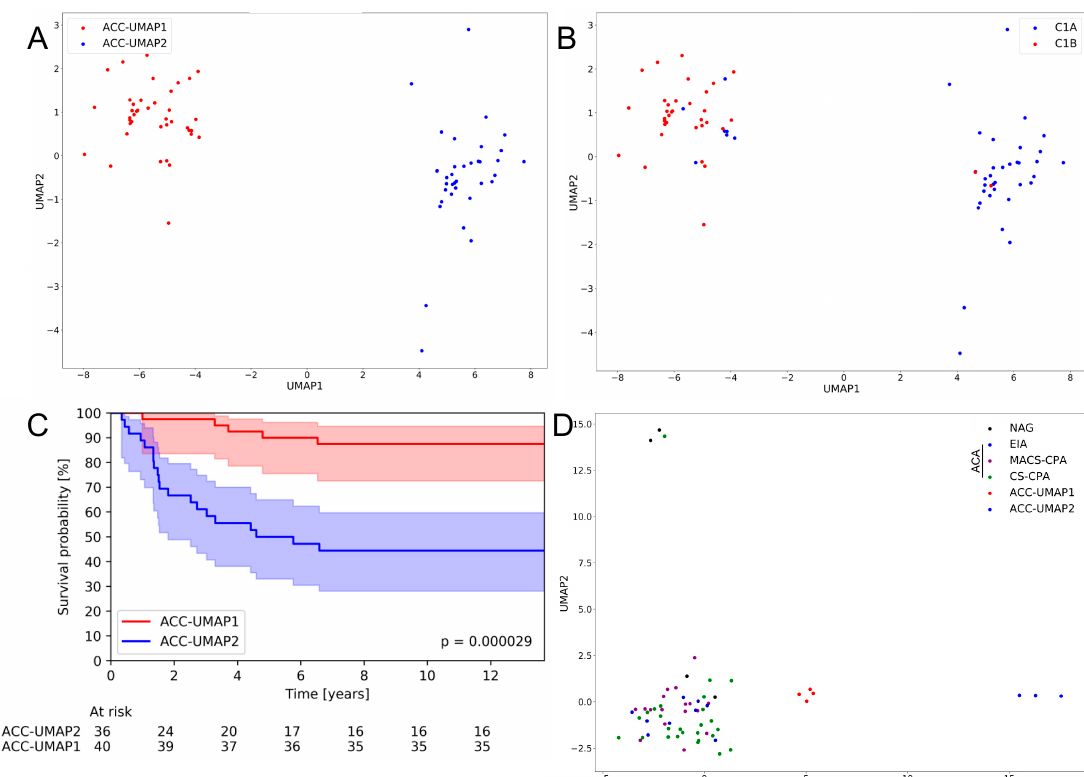
Figure 1. UMAP cluster representation of different mRNA expression patterns. Representation of the UMAP (uniform manifold approximation and projection) clustering of the ACC-TCGA dataset without outliers ( A ) and the overlap with C1A/C1B clustering from the original publication of Zheng et al. [15] ( B ). Kaplan–Meier curve of overall survival of ACC-TCGA patients assigned to the two clusters by UMAP. Shaded area: confidence interval with alpha = 0.05 ( C ). Representation of the UMAP clustering of the ENSAT dataset [19] ( D ). NAG = normal adrenal gland; EIA = endocrine inactive adenoma; MACS-CPA = mild autonomous cortisol secretion adenoma-cortisol producing adenoma; CS-CPA = Cushing syndrome-cortisol producing adenoma which together make the ACA = adrenocortical adenoma; ACC = adrenocortical carcinoma.